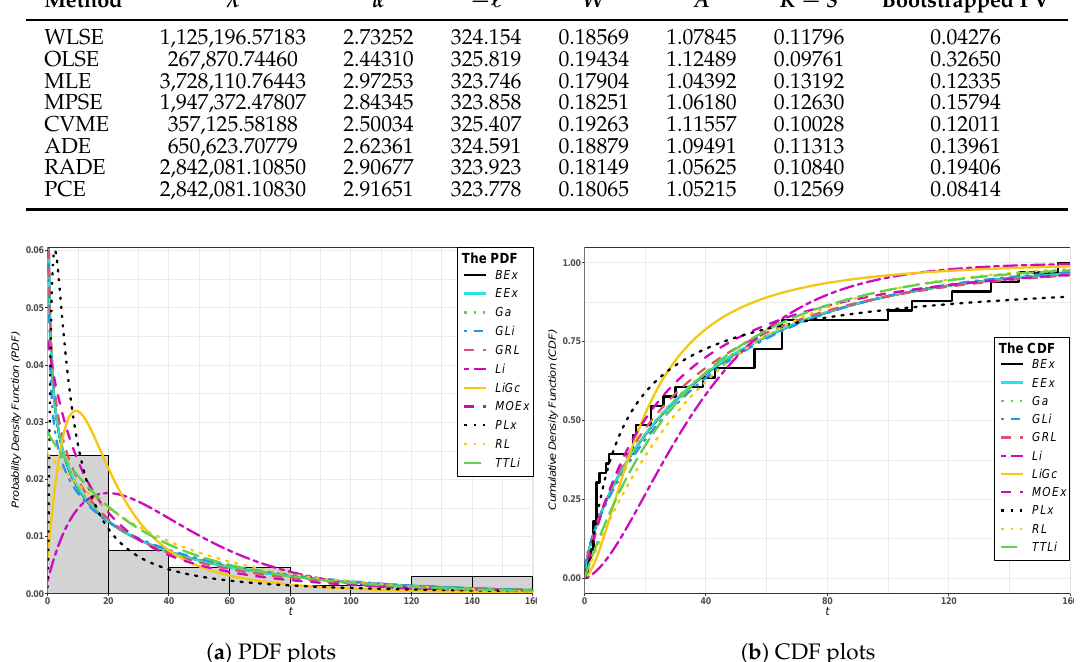
Figure 3. Fitted densities and distribution functions of the competing models for leukemia data.